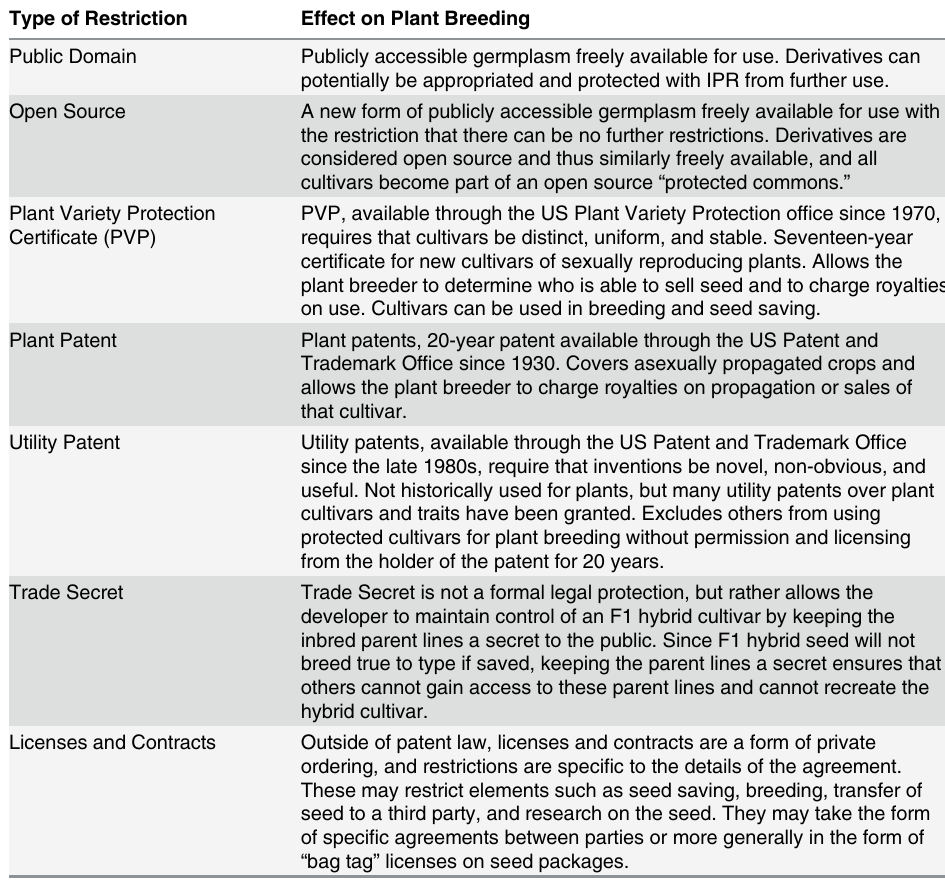
Table 1. Germplasm IPRs and their effects on plant breeding. For more detail on IPR protections (excluding Open Source), see